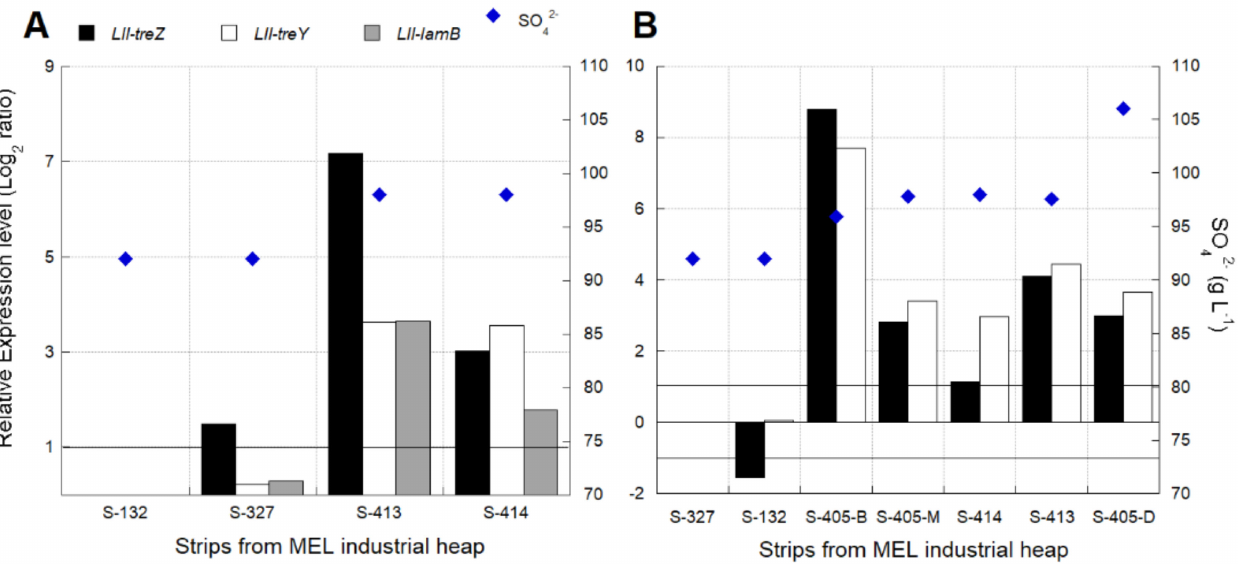
Figure 10. Transcriptional dynamics of treZ , treY , and lamB genes of L. ferriphilum (LII) from industrial bioleaching strips with different operational times (Table 2) and sampling ( A ) at the same date (23 August 2017) or ( B ) at different dates (11 November 2015, and 23 August 2017, Table 2). The gene lamb was not amplified in S-405-D (from drop), S-405-B (from the base of the second lift), and S-405-M (from the base of the fourth lift) (Table 2). Significant differences in relative expression were adjusted at − 1 < Log 2 ratio < 1 (horizontal black lines). Gene expression was calculated relative to the control samples (log 0 values) that correspond in ( A , B ), respectively, to S-132 and S-327.